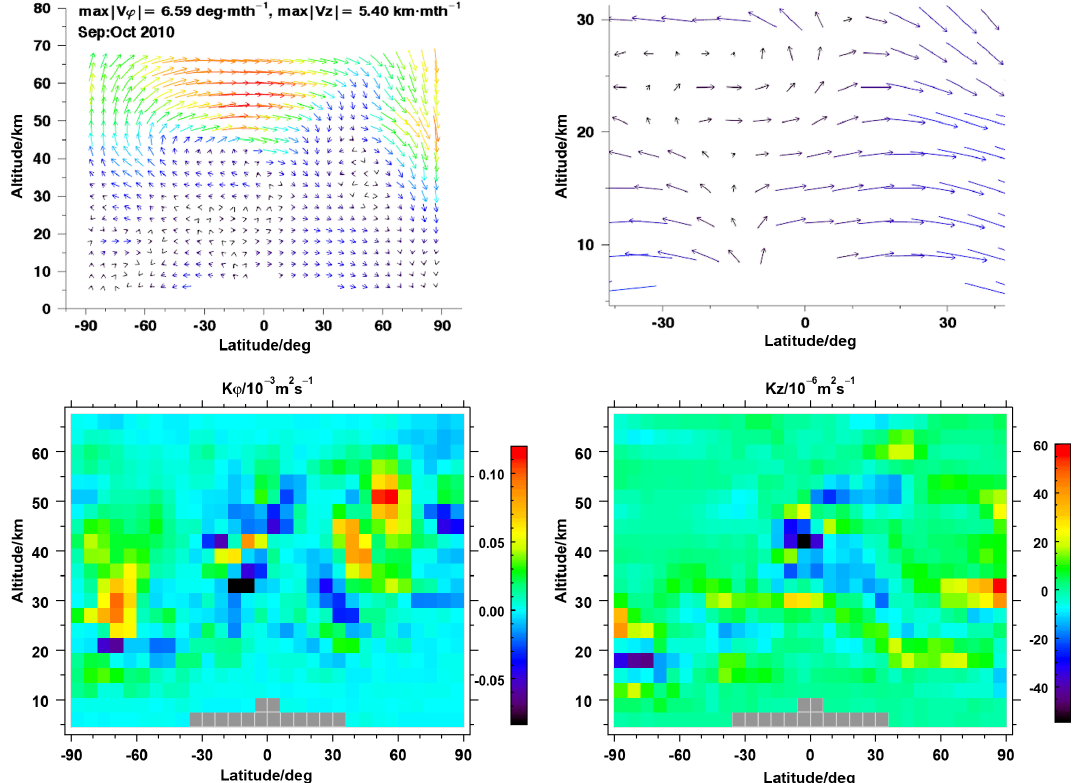
Figure 4. Resulting circulation vectors ( v(z,φ),w(z,φ )) (upper left panel), where colors on the red side of the rainbow color scale represent higher velocities; a zoomed-in view of this (upper right panel); mixing coefficients K φ (lower left panel) and K z (lower right